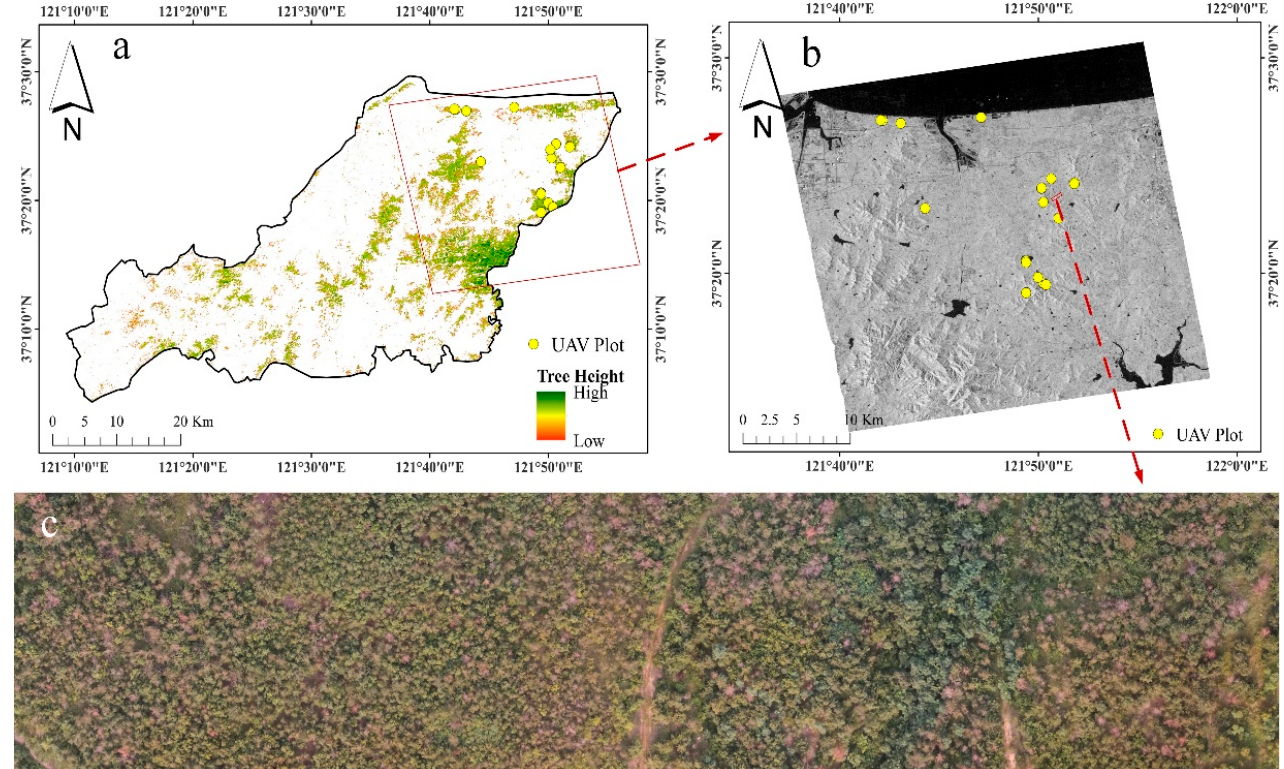
Figure 1. Overview of study area. ( a ) Study area with background image of tree height in study area; ( b ) Radarsat-2 image and 17 plots of field campaign; ( c ) perspective view of a PWN-infested forest plots shown by an UAV RGB image.